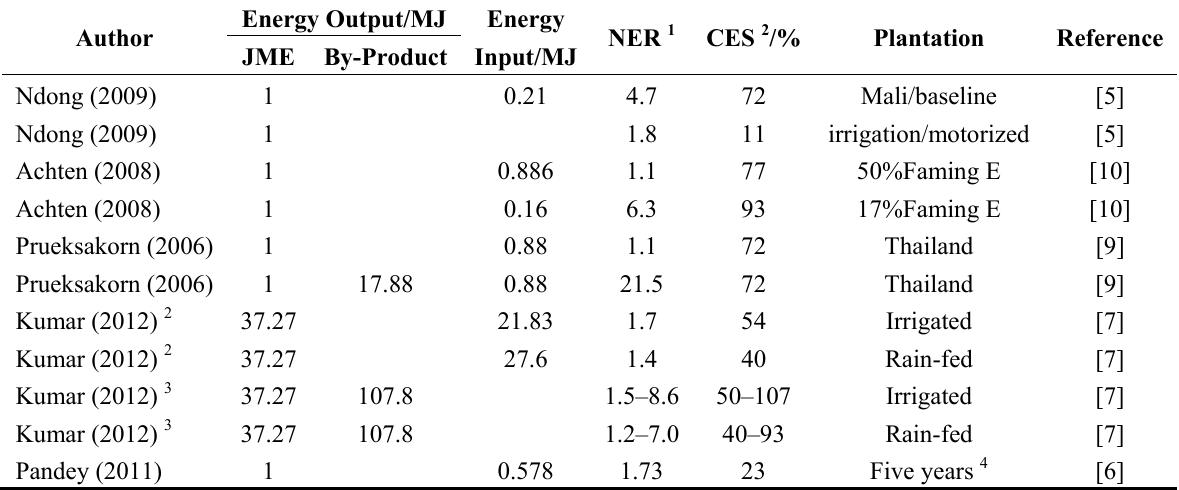
emission saving 2